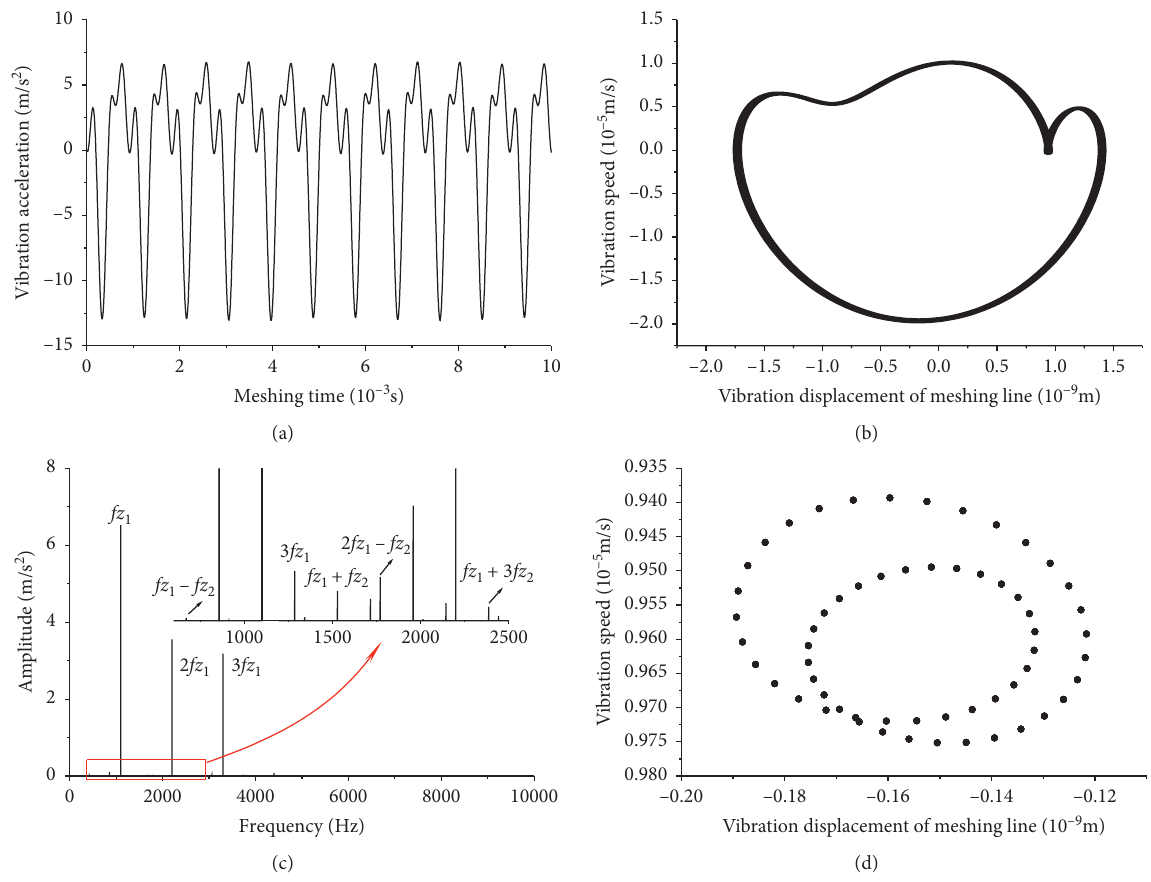
Figure 11: Vibration response of the input-stage gear pair of a two-stage helical gear transmission system at 3,000rpm: (a) time-domain diagram, (b) phase diagram, (c) frequency-domain diagram, and (d) Poincar´e meshing frequency of the input-stage gear pair; however, the is more obvious in the output-stage gear pair, as shown in response frequency amplitude related to the meshing fre- Figure 12(c); in the frequency response of the output-stage quency of the output-stage gear pair is not that large. gear pair, the higher amplitudes are mostly related to the